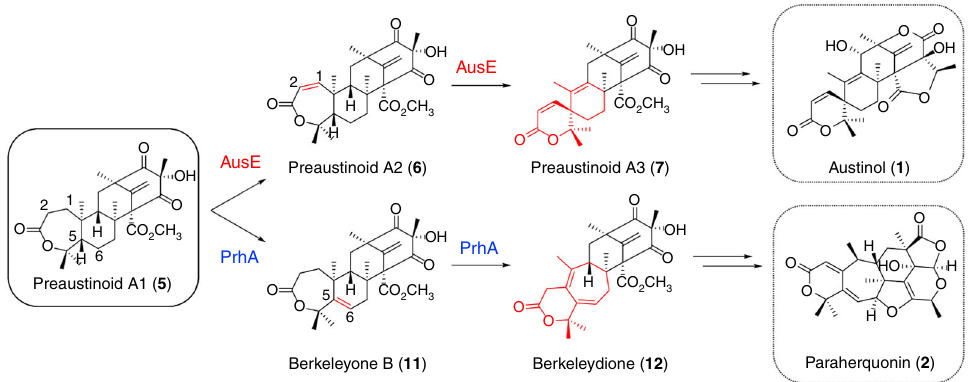
Fig. 1 Reactions catalyzed by AusE and PrhA oxygenases from preaustinoid A1 ( 5 ). AusE and PrhA use preaustinoid A1 ( 5 ) as a common substrate to catalyze divergent multistep oxidation reactions in austinol ( 1 ) and paraherquinonin ( 2 ) biosynthetic